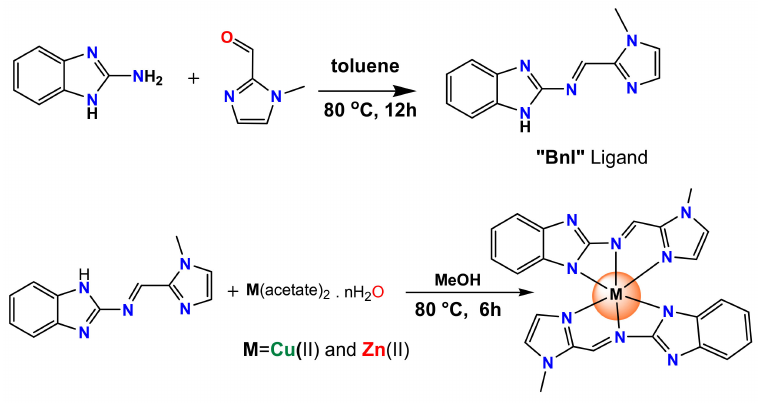
Figure 1. Schematic representation of the synthesis of the benzimidazole-derived ligand and its copper(II) complex [Cu(BnI) 2 ], 1 and zinc(II) complex, [Zn(BnI) 2 ], 2